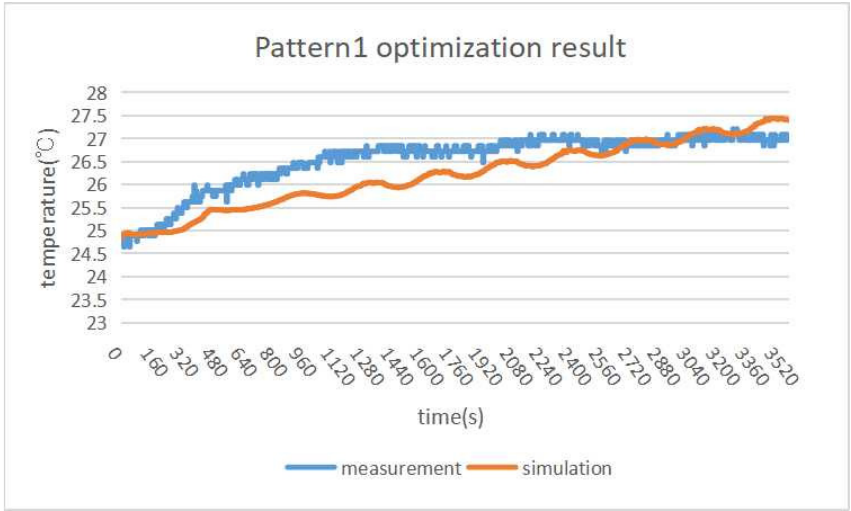
Figure 18. Simulation result after optimization with pattern1